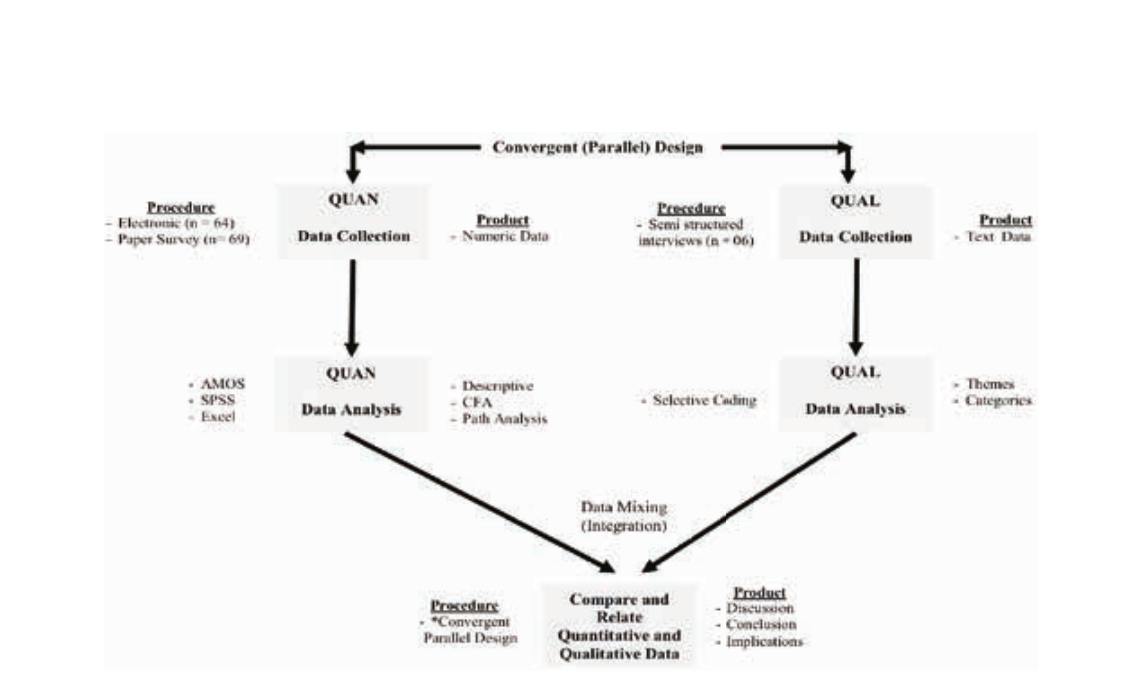
Figure 5. Mixed-Method Research Design – Creswell